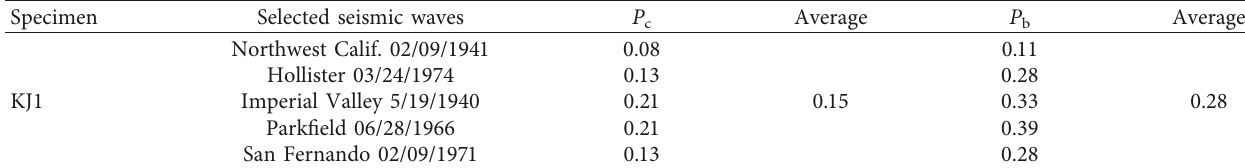
Table 6: Plastic hinge rates of beams and columns in model KJ1.